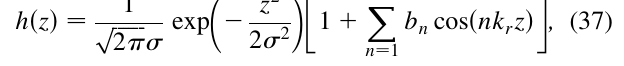
(cid:2) (cid:6) (cid:4) and (cid:10) (cid:2) (cid:6) (cid:4) obtained i i